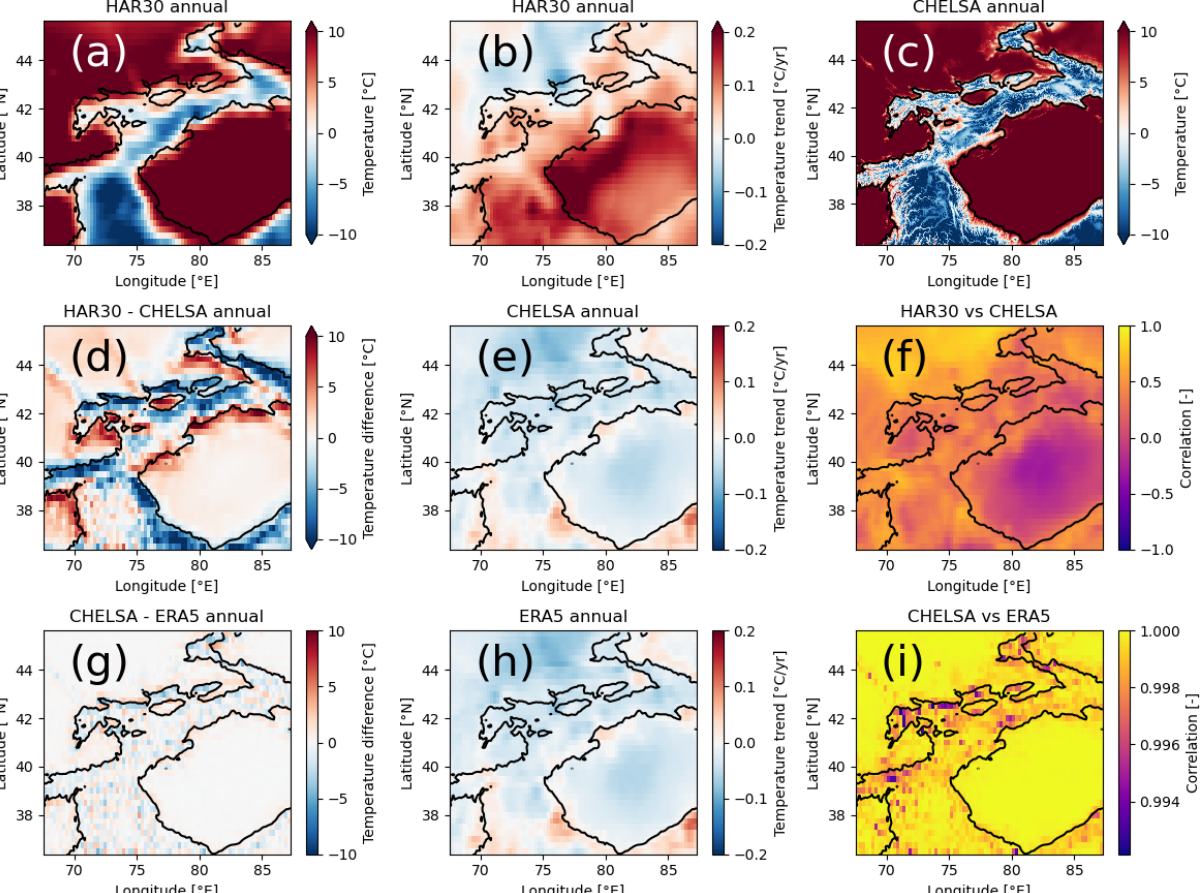
Figure A2. Mean annual temperature for (a) HAR30 and (c) CHELSA. Trends for (b) HAR30, (e) CHELSA, and (h) ERA5. Differences between the datasets (d) HAR30 and CHELSA and (g) CHELSA and ERA5 and the correlation between (f) HAR30 and CHELSA and (i) CHELSA and ERA5. CHELSA and ERA5 are spatially resampled to the resolution of HAR30 for the differences and correlation. Note the different scale for the correlation in (i) . Black outlines correspond to 2000ma.s.l.